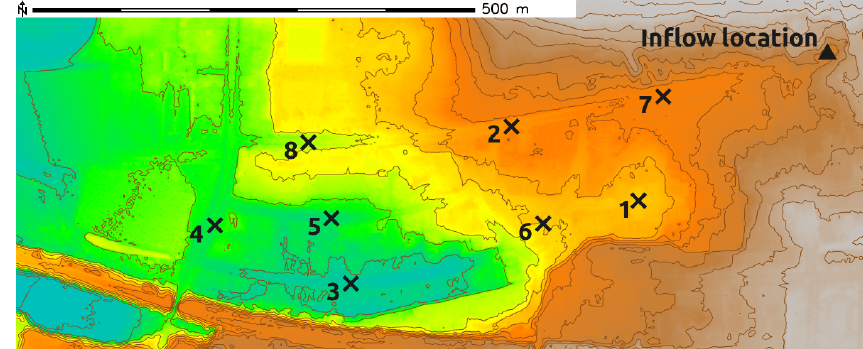
0.00.10.20.30.40.50.60.70.8